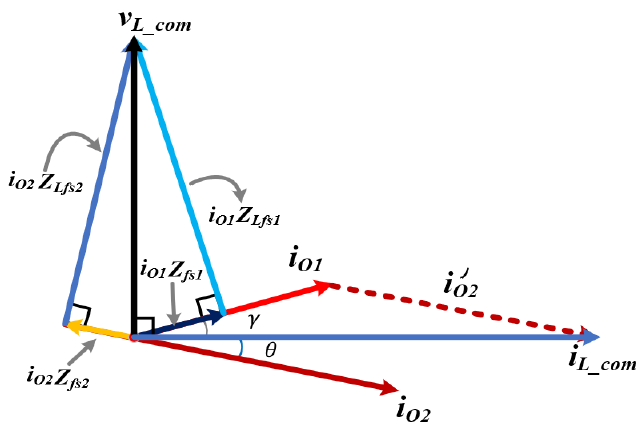
Figure 29. The phasor diagrams of equivalent circuit model with common inductor connection.